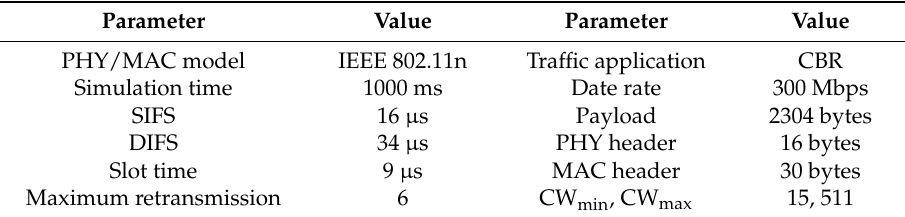
Figure 4. Examples of network topology: ( a ) four devices; ( b ) eight devices; ( c ) 14 devices; and ( d ) 20 devices. Table 1. Simulation parameters.